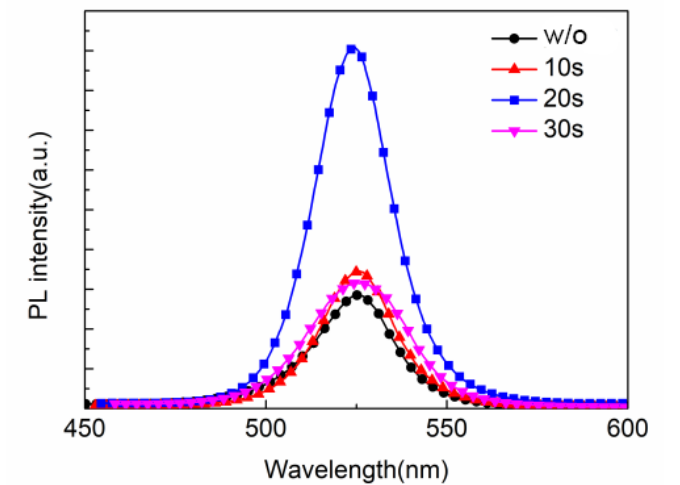
Figure 1. Photoluminescence spectra of perovskite films treated with ethyl acetate dropwise at different times.